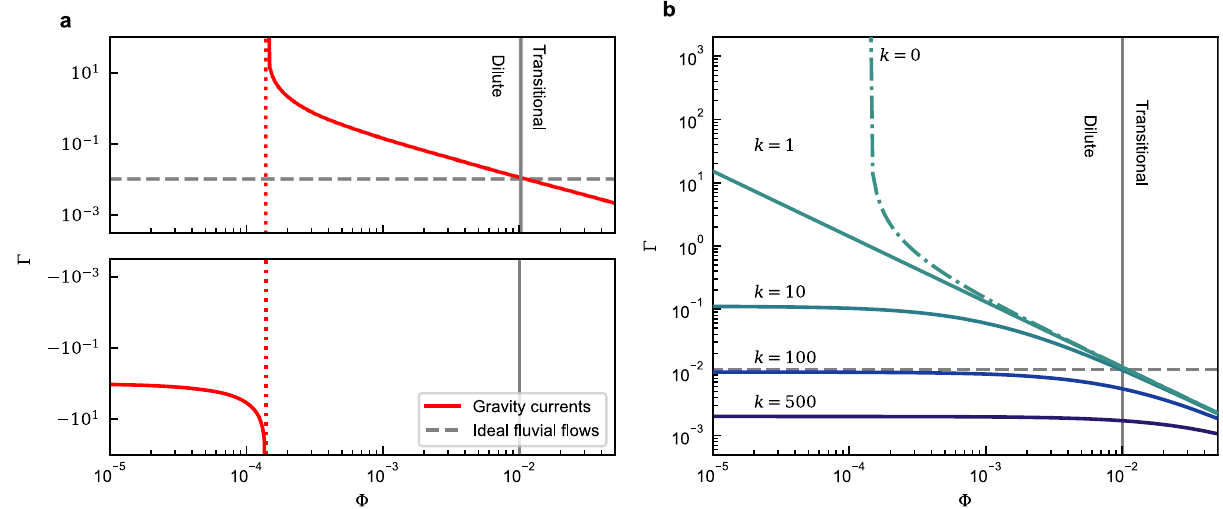
Fig. 4 | Predictedturbulent fl ux coef fi cient. The turbulent fl ux coef fi cient, Γ , as a function of concentration, Φ . a Computed Γ , assuming P = P th and S =0. The red dottedlineindicatestheverticalasymptoteforthegravitycurrentcurve(redsolid). b Computed Γ ,assuming P = P th + S ,wheretheadditionalenergyisparameterisedin